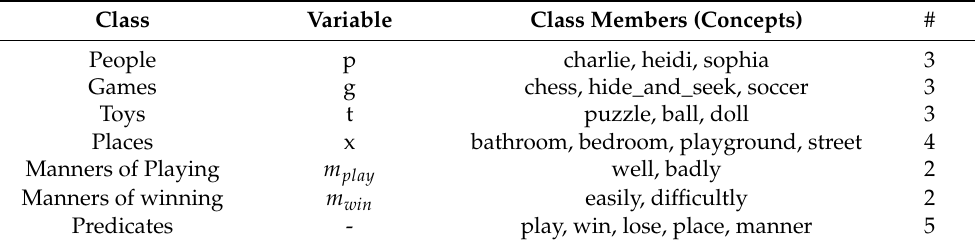
Table 1. Concepts in the microworld of Frank et al.